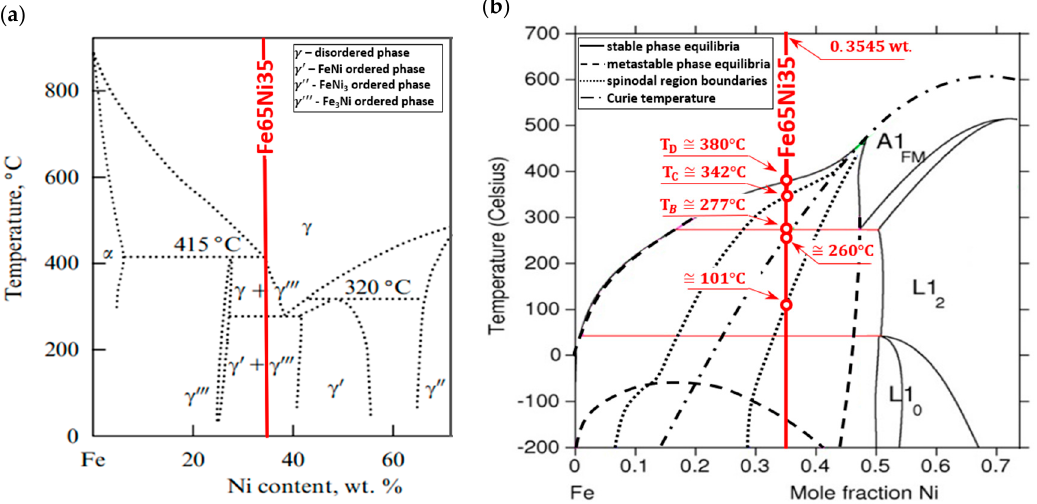
Figure 11. Investigated Fe65Ni35 alloy marked on fragments of Fe–Ni phase diagrams proposed by ( a ) Chamberod et al. [31], and ( b ) Cacciamani et al. [26], covering only phases based on a FCC crystal